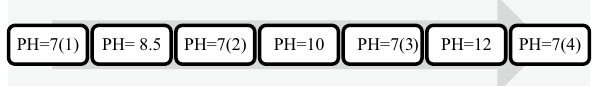
Fig. 3 The flooding schedule of fluids with different alkalinity (pH) in Fahliyan core